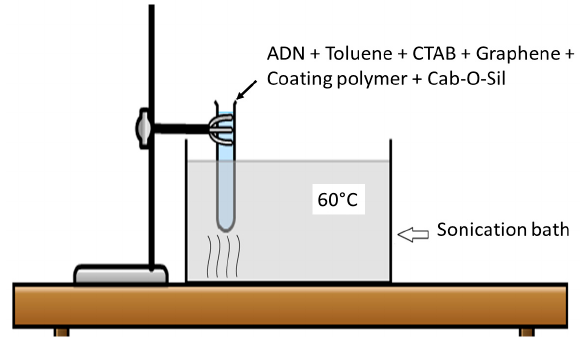
Figure 1. Experimental setup of Ammonium Dinitramide (ADN) sonication. Pristine ADN particles sonicated in toluene mixture.